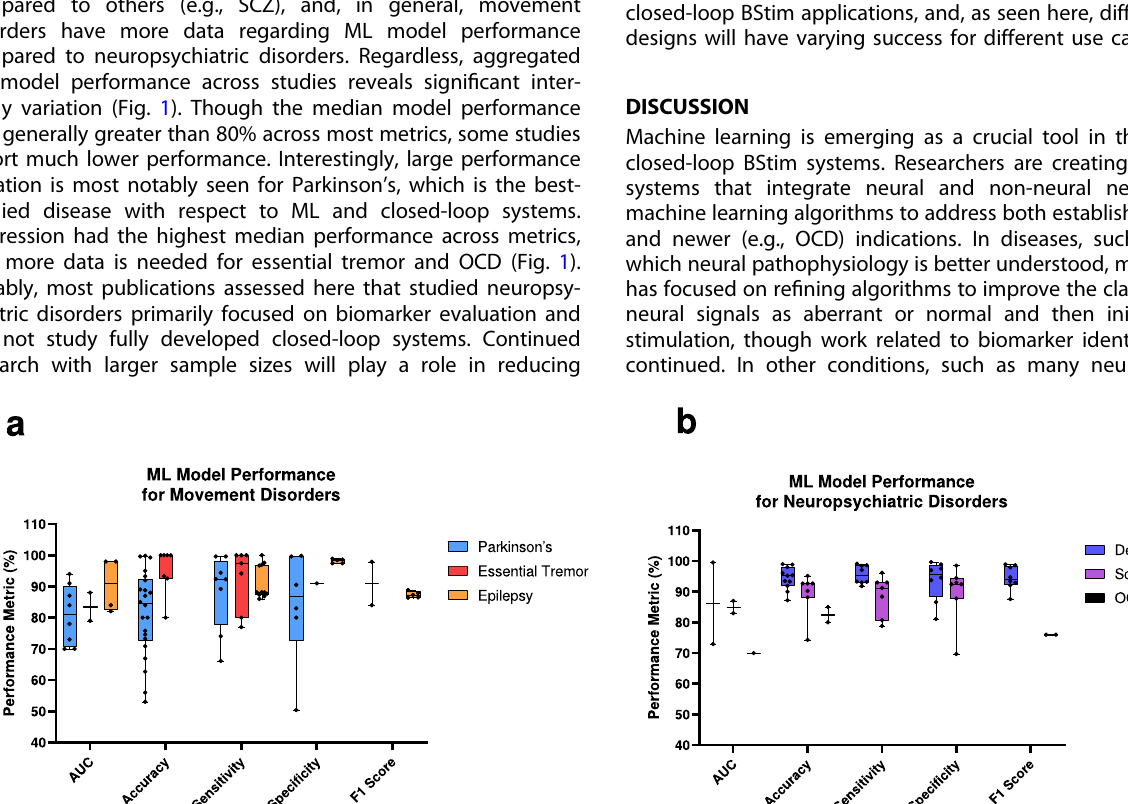
based algorithm to classify OCD versus healthy controls (Table 6). When tested on an external data set, the algorithm achieved an AUC of 0.7 88 . Another group applied gradient-boosted decision trees and SVM on facial recordings of patients with OCD to differentiate between pre- and post-stimulation adjustment states. By analyzing various facial landmarks, Ding et al. found that both gradient boosted decision trees and SVM differentiated between fewer features to achieve the same F1 score 89 .